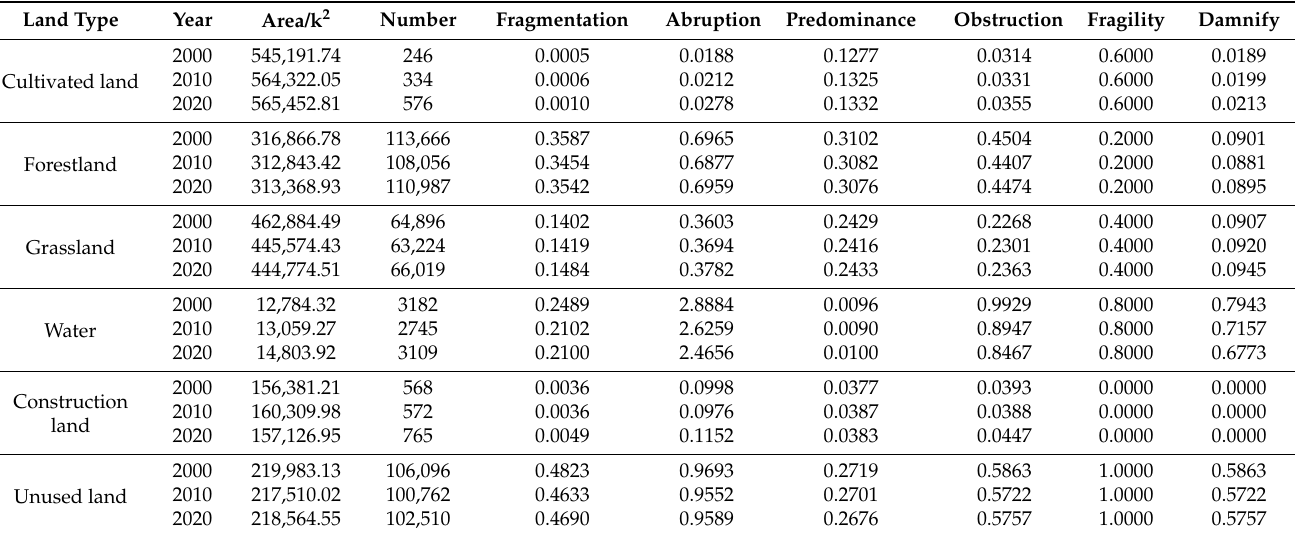
Table A5. Landscape pattern index of Tashkent City from 2000 to 2020.